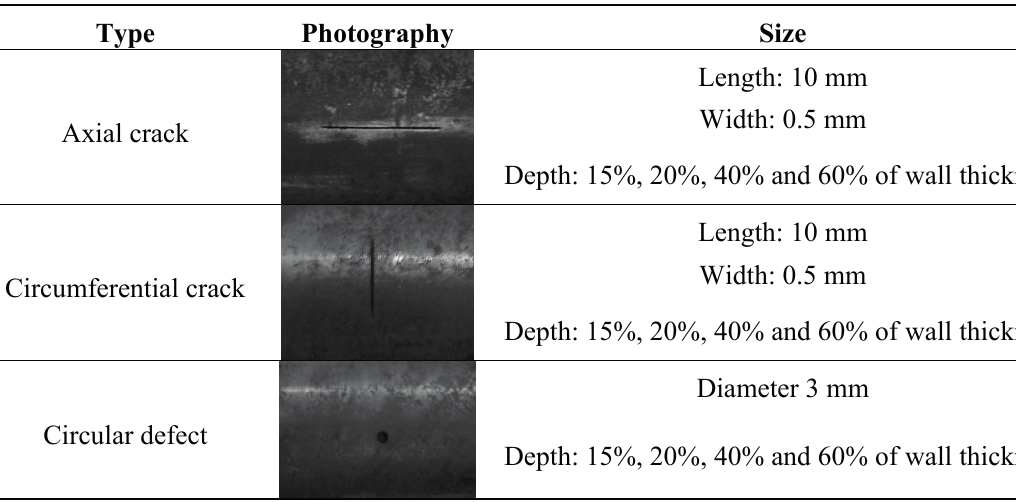
circumferential field pick-up coil and radial field pick-up coil are used to verify the detection sensitivity of orthogonal magnetic field excitation. Table 2. Parameters of the test